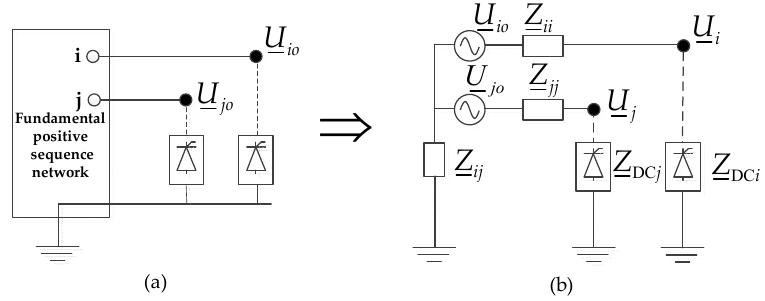
Figure 11. Schematic diagram of a double DC infeed system: ( a ) the original structure of the double DC infeed system; ( b ) the Thevenin equivalent circuit of the double DC infeed system.